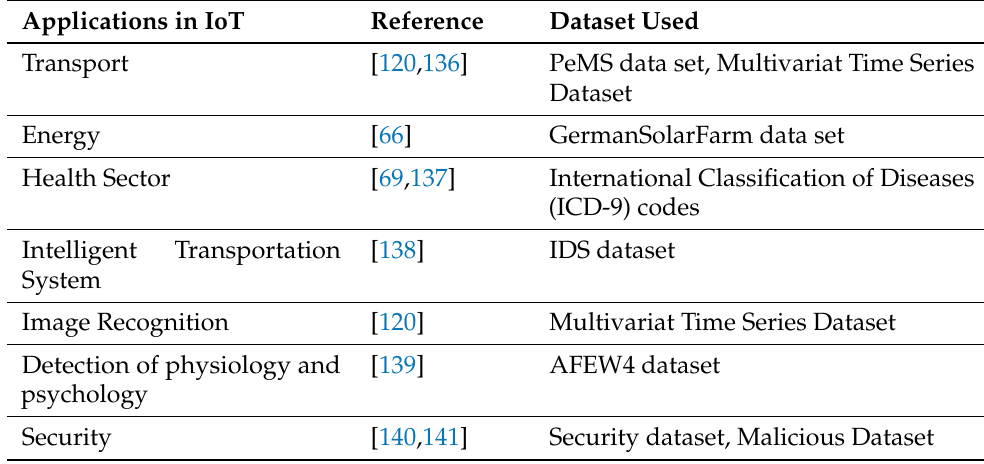
Table 6. DBN model in IoT